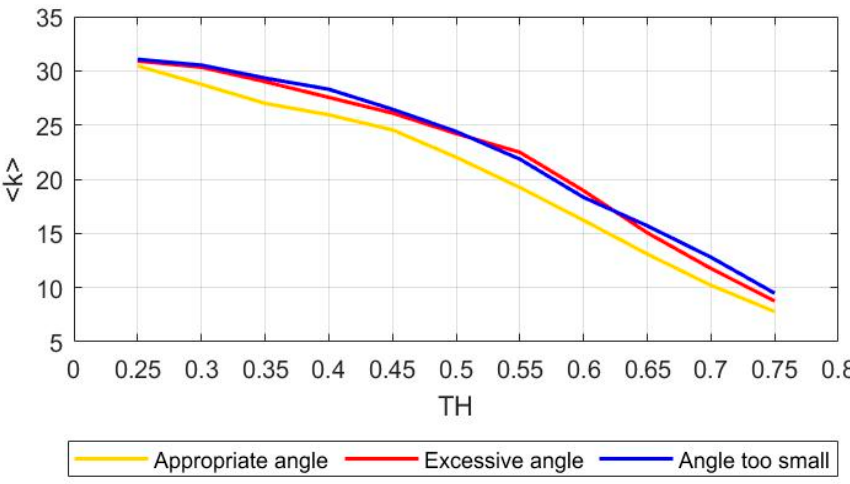
Figure 5. Changes in average node degree under different thresholds.